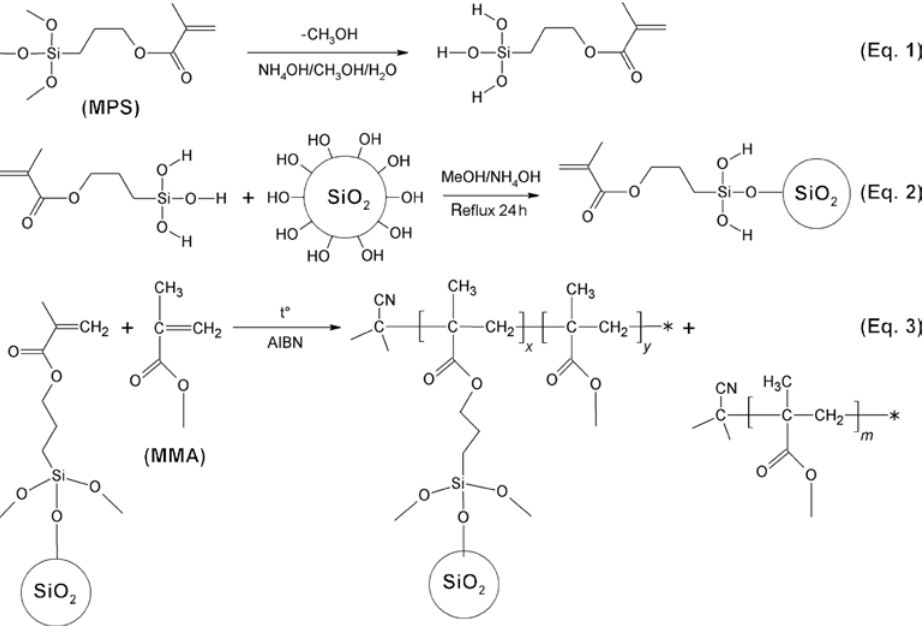
hybrid particles. 2